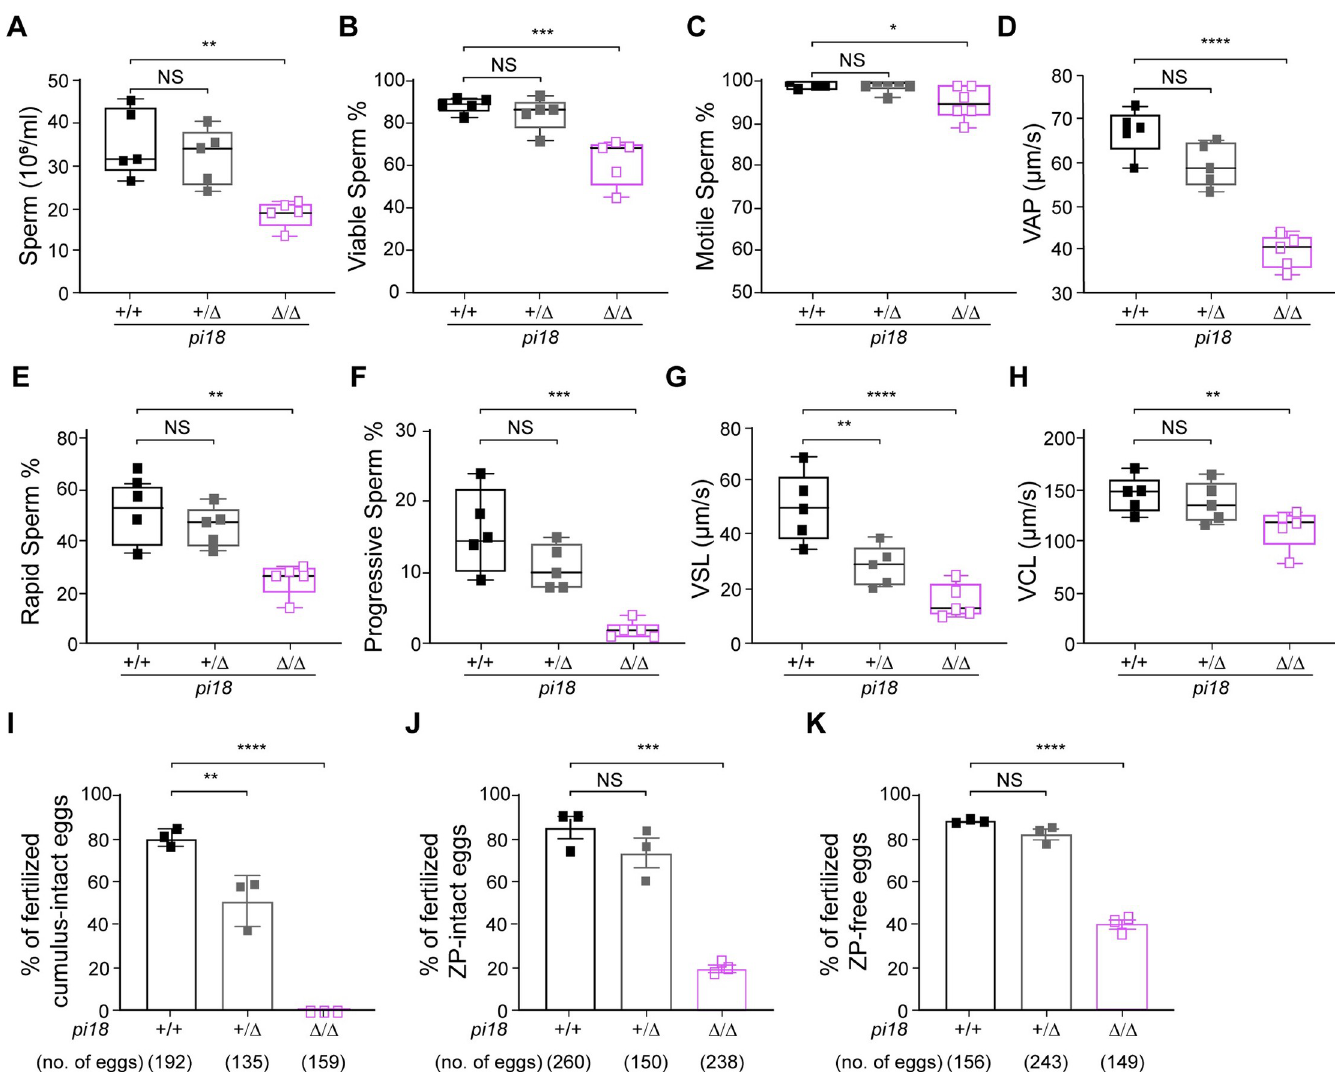
Fig 2. Impaired motility and in vitro fertilization with pi18 Δ / Δ sperm. (A) Sperm counts from 8 wk/old mice from pi18 +/+ (black square), pi18 +/ Δ (grey square), and pi18 Δ / Δ (purple square) mice ( n = 5 for each genotype). (B) Sperm viability was determined by the nuclear dye Hoechst 33342 staining. The viable spermatozoa, which fluoresced pale-blue with Hoechst 33342, was expressed as a percent of the number of viable sperm/total sperm. (C) Computer-Assisted Sperm Analysis (CASA) assay of average sperm motility from 8 wk/old mice ( n = 5 for each genotype). (D) Path velocity (velocity average path, VAP). (E) Rapid sperm motility (% of motile sperm with VAP � 10 μ m/s). (F) Progressive motility (% of motile sperm with VAP � 50 μ m/s and STR = VSL/VAP � 50%, straightness, STR). (G) Linear velocity (velocity straight line, VSL). (H) Track velocity (velocity curvilinear, VCL). The box indicates median ± interquartile range, the whiskers indicate the highest/lowest values and midlines are the median values. (I) pi18 Δ / Δ sperm are unable to fertilize wildtype eggs in vitro . Controls and pi18 Δ / Δ sperm were inseminated with cumulus-intact eggs for 3 hours, (J) ZP-intact eggs for 3 hours and (K) ZP-free eggs for 2 hours. The average fertilization rate (mean ± s.d.) from three independent experiments is presented. Each square represents individual male mice that were used for IVF. The total number of analyzed eggs per condition is in the parenthesis. NS, not significant, � P < 0.05, �� P < 0.01, ��� P < 0.001, and ���� P <